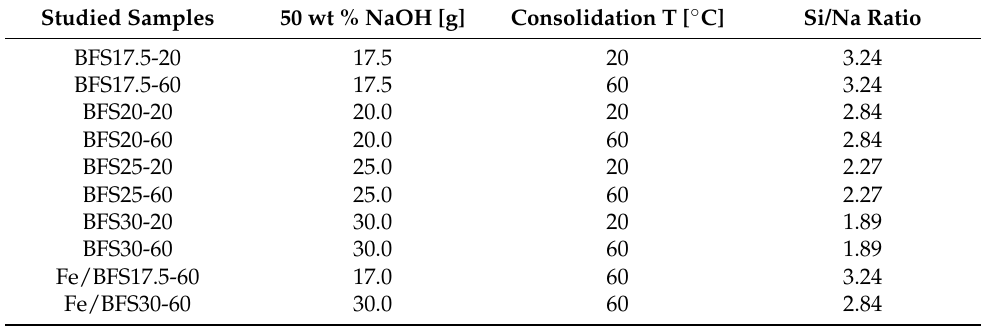
Table 6. Abbreviations of the prepared AAMs and Fe catalysts. Samples were named according to their NaOH concentrations and curing